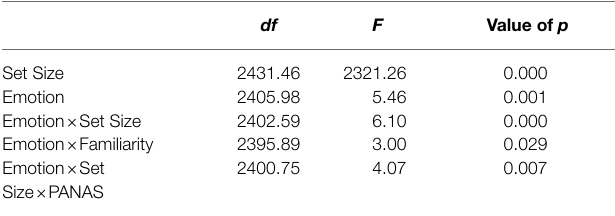
TABLE 2 | Significant main effects and interactions from the LMM with participant as a random effect, emotion as a categorical fixed effect, PANAS as a continuous fixed effect, and coded familiarity and set size as continuous fixed